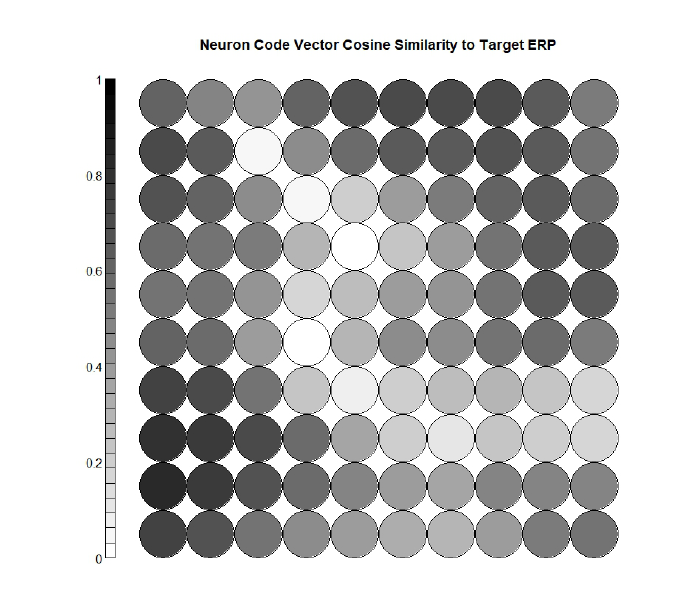
Figure 10. Cosine similarity between averaged Target ERP and code vectors.